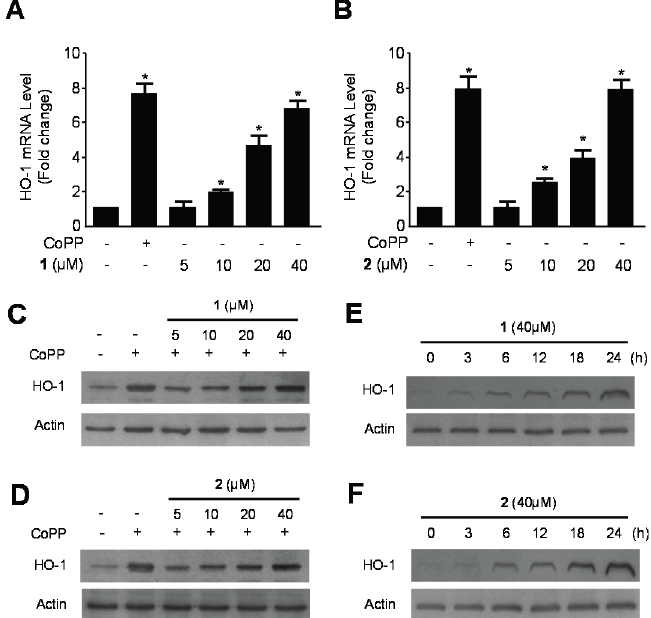
Figure 2. Effects of 1 and 2 on heme oxygenase-1 (HO-1) mRNA ( A , B ) and protein ( C – F ) expression in RAW264.7 macrophages. RAW264.7 macrophages were incubated with indicated concentrations of 1 and 2 for 12 h ( A – D ). For the time-course study, the cells were incubated with 1 and 2 (40 μ M) for the indicated times ( E , F ). Data are represented as the mean ± S.D. of 3 independent experiments. Cobalt protoporphyrin (CoPP) (20 μ M) was used as the positive control. * p < 0.05 vs. control.